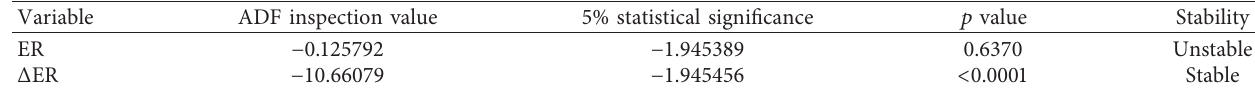
Figure 11: Timing diagram of popularity of Topic 20 after 1st-order differencing. Table 5: Stability test.